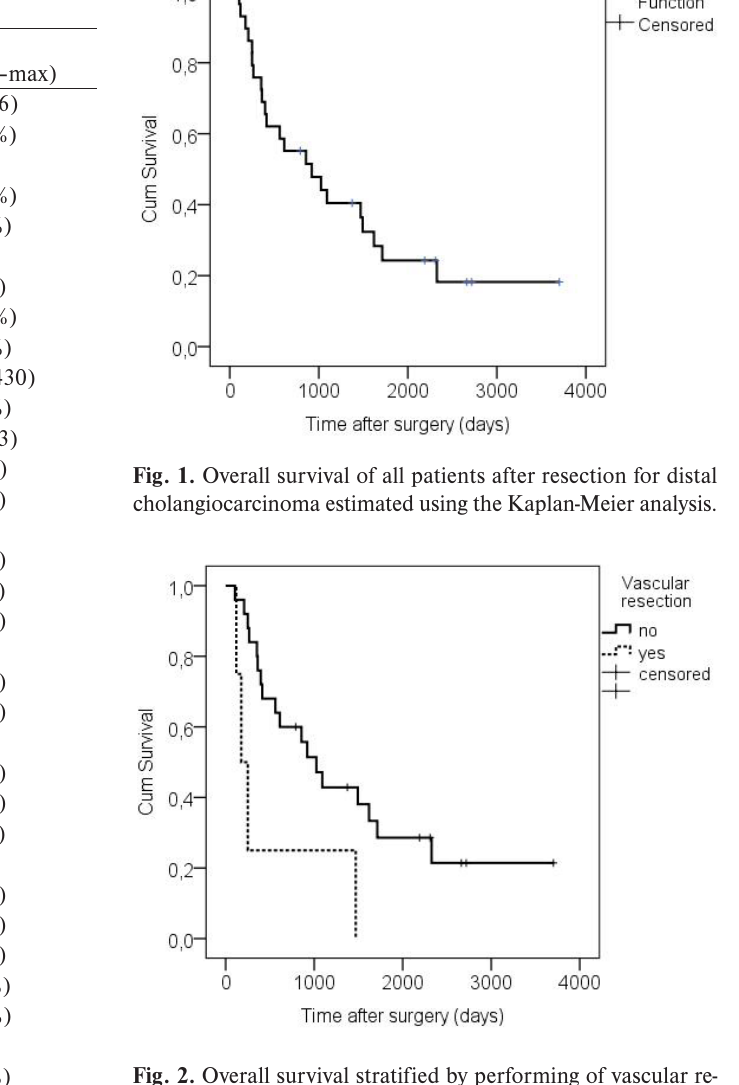
Table 1. Clinicopathological and perioperative data for pa- tients with distal adenocarcinoma.